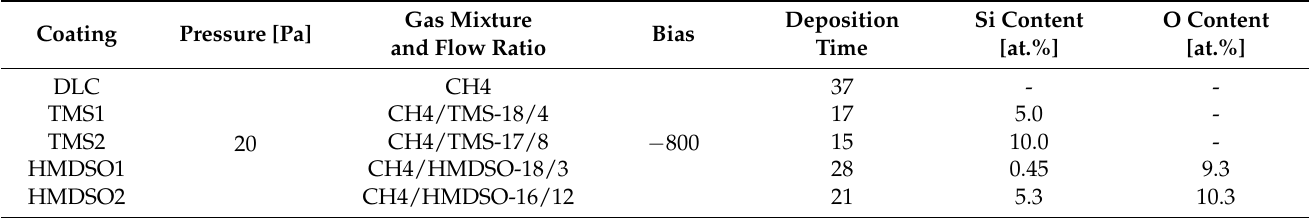
Table 1. Basic parameters of synthesis of 1 µ m thick DLC and silicon-incorporated DLC